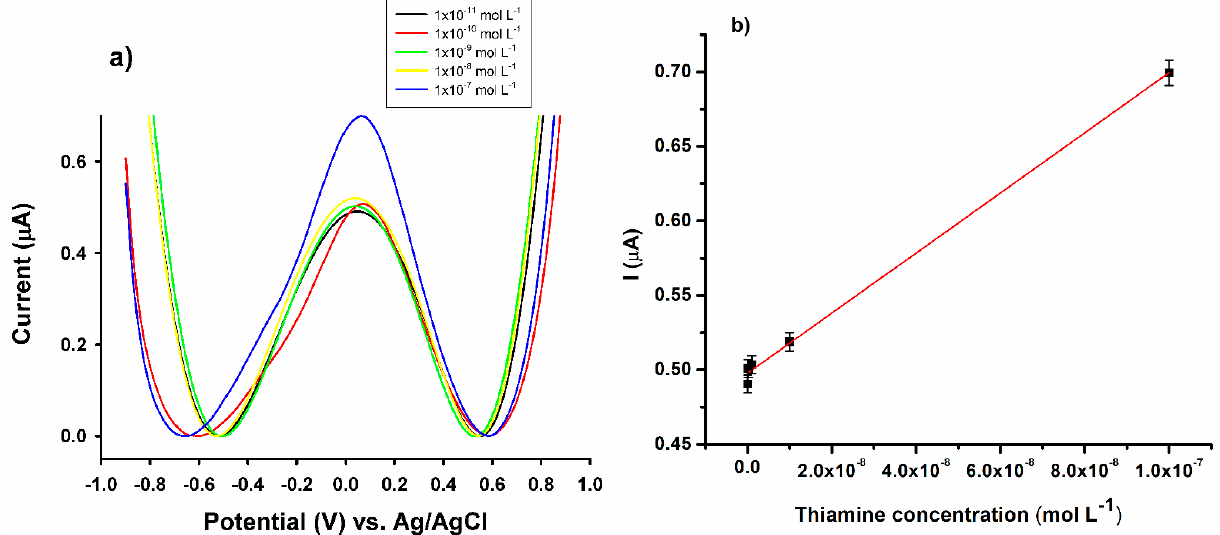
Figure 8. ( a ) Differential pulse voltammograms recorded with PIXCoCl/AuNPsnGr sensor in PBS pH 2.0 and 0.1 mol L -1 NaNO 3, containing different concentrations of thiamine from 1.0 × 10 -11 mol L -1 to 1.0 × 10 -7 mol L -1 . ( b ) Calibration curve obtained with PIXCoCl/AuNPsnGr sensor from 1.0 × 10 -11 mol L -1 to 1.0 × 10 -7 mol L -1 . Working conditions: step potential 0.025 V, amplitude: 0.1 V. Table 1. Response characteristics of the 3D electrochemical sensors used for detection of thiamine.